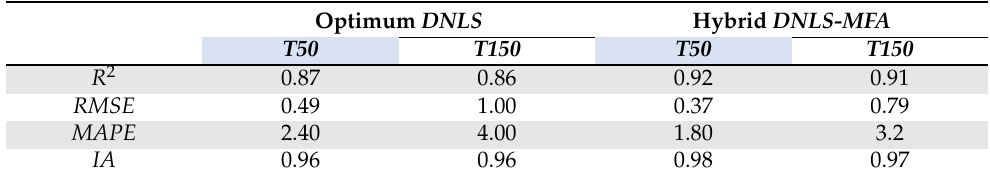
Table 2. Evaluated error metrics of the predicted temperatures using validation datasets.